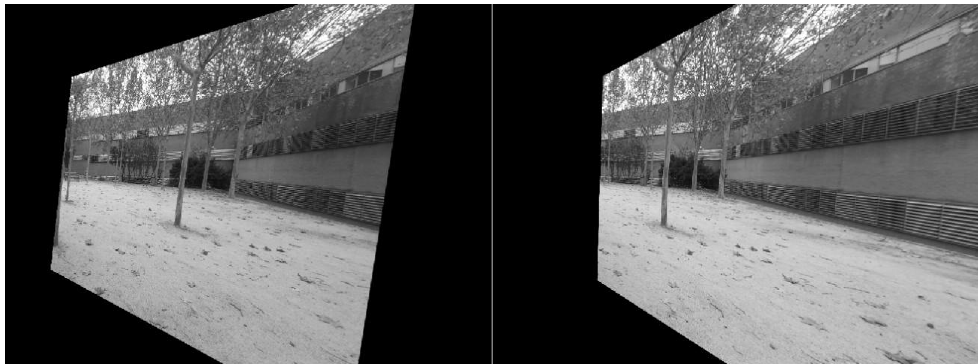
Figure 3. Pair of images rectified according to [31].